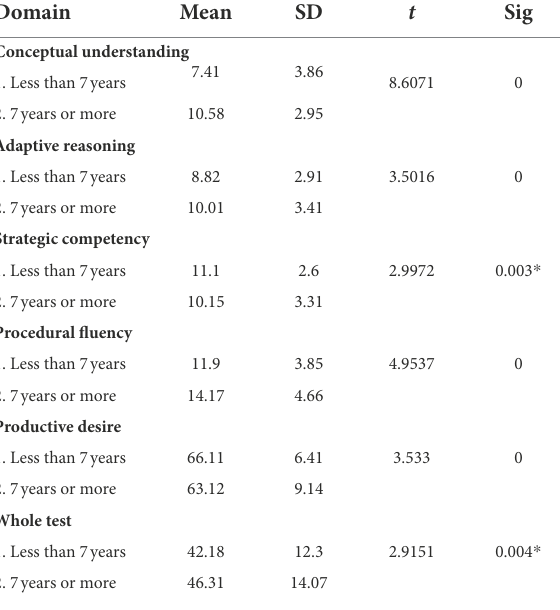
TABLE 2 Independent samples t -test for the differences in the mathematical proficiency based on the participants’ years of